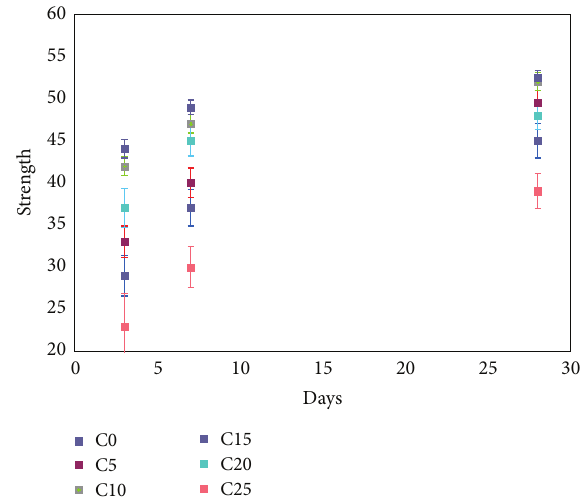
Figure 1: Scatter plot on strength of mortar cubes with standard